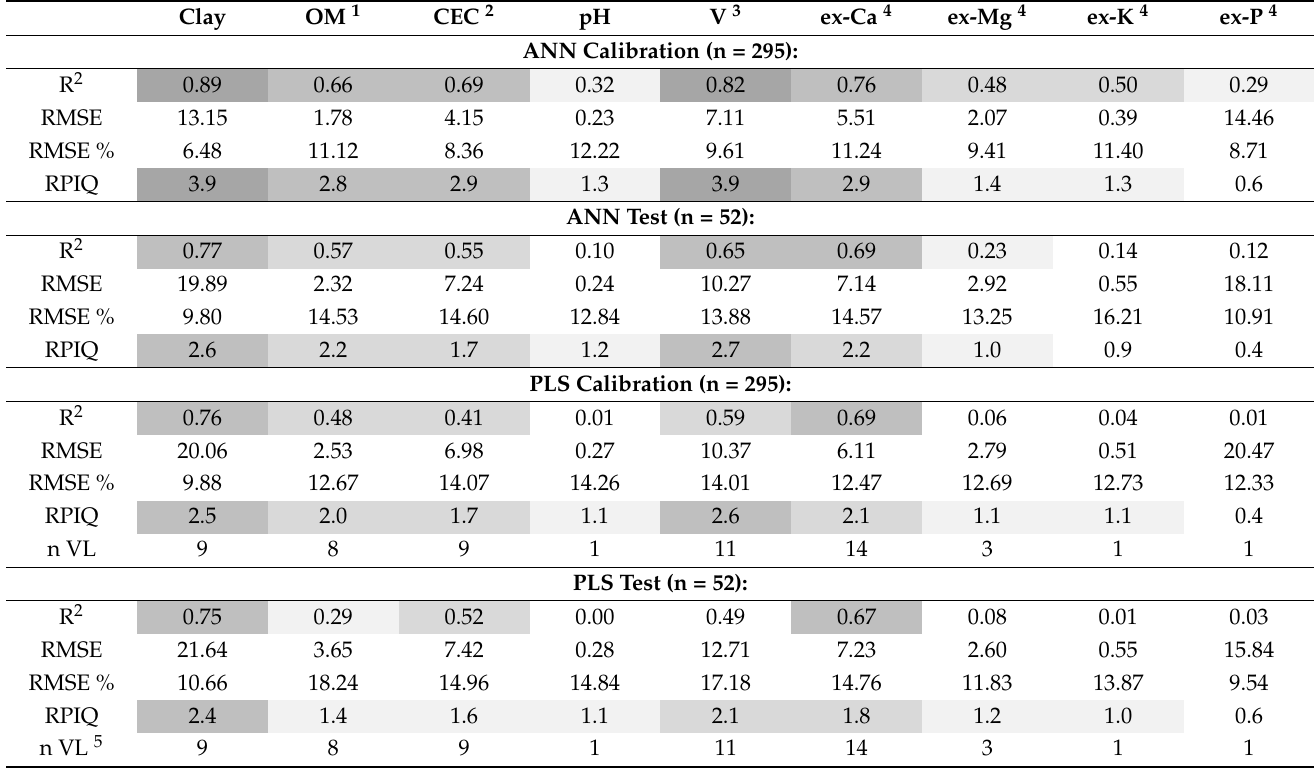
Table 2. Prediction results of the calibration and test set obtained from partial least squares regression (PLS) and artificial neural network (ANN) models calibrated using mobile visible and near-infrared spectroscopy (vis–NIR) in the calibration